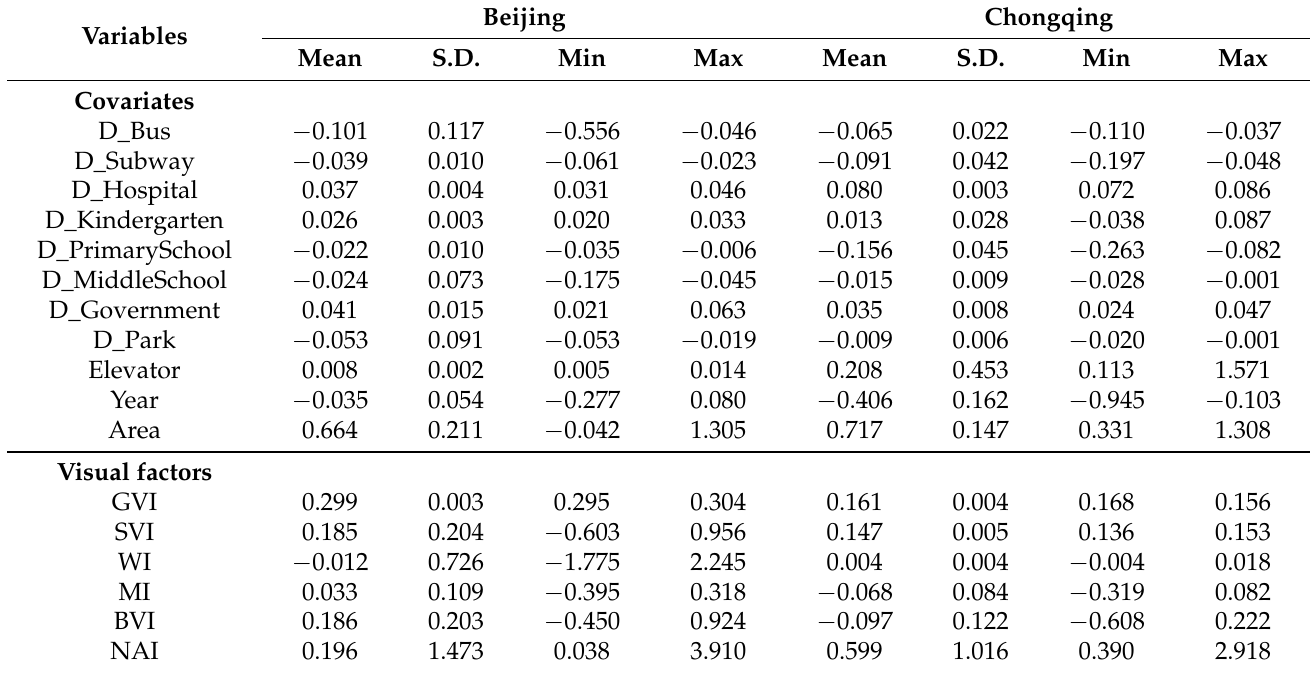
Table 7. MGWR regression coefficient statistical